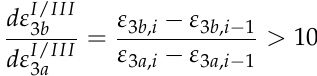
Figure 3. Bifurcation conditions of the failure criteria of the polymer layer: ( a ) Term 1 was larger than Term 2; ( b ) Term 1 was initially larger than Term 2 and became equal at a given point; ( c ) Term 1 was initially larger than Term 2 and became smaller at a given point; ( d ) Term 1 was smaller than Term 2. It was advised to limit the solution domain to be positive with an initial estimate of 0 when solving Equation (21). Once ε 1 was solved, the pressure on each interface could be obtained by using Equations